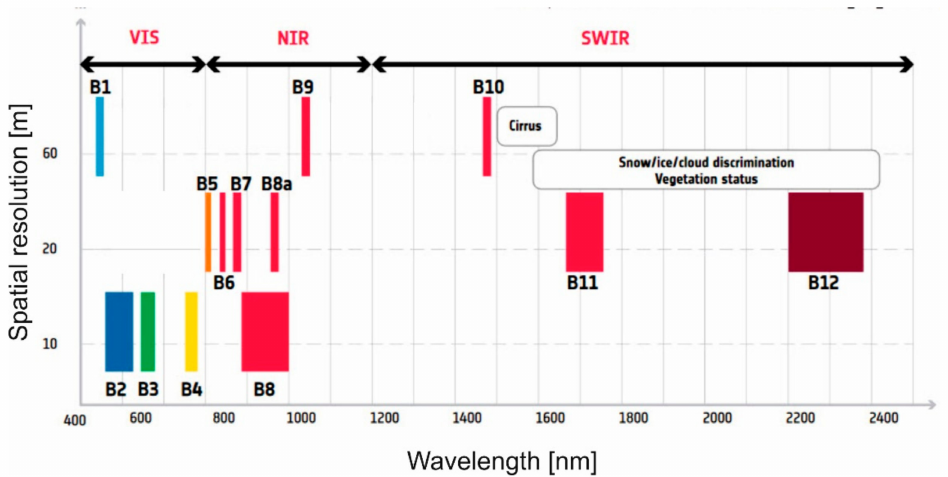
Figure 2. Spatial resolution versus wavelength for Sentinel-2 along the visible (VIS), Near-Infrared (NIR) and Short-Wave-Infrared (SWIR) spectra. The two labeled white boxes indicate the spectral bands with specific applications for atmospheric correction phenomena that need to be allowed for when selecting Sentinel-2 data for use in coastline mapping. Modified from http: // esamultimedia.esa.int / docs / EarthObservation /